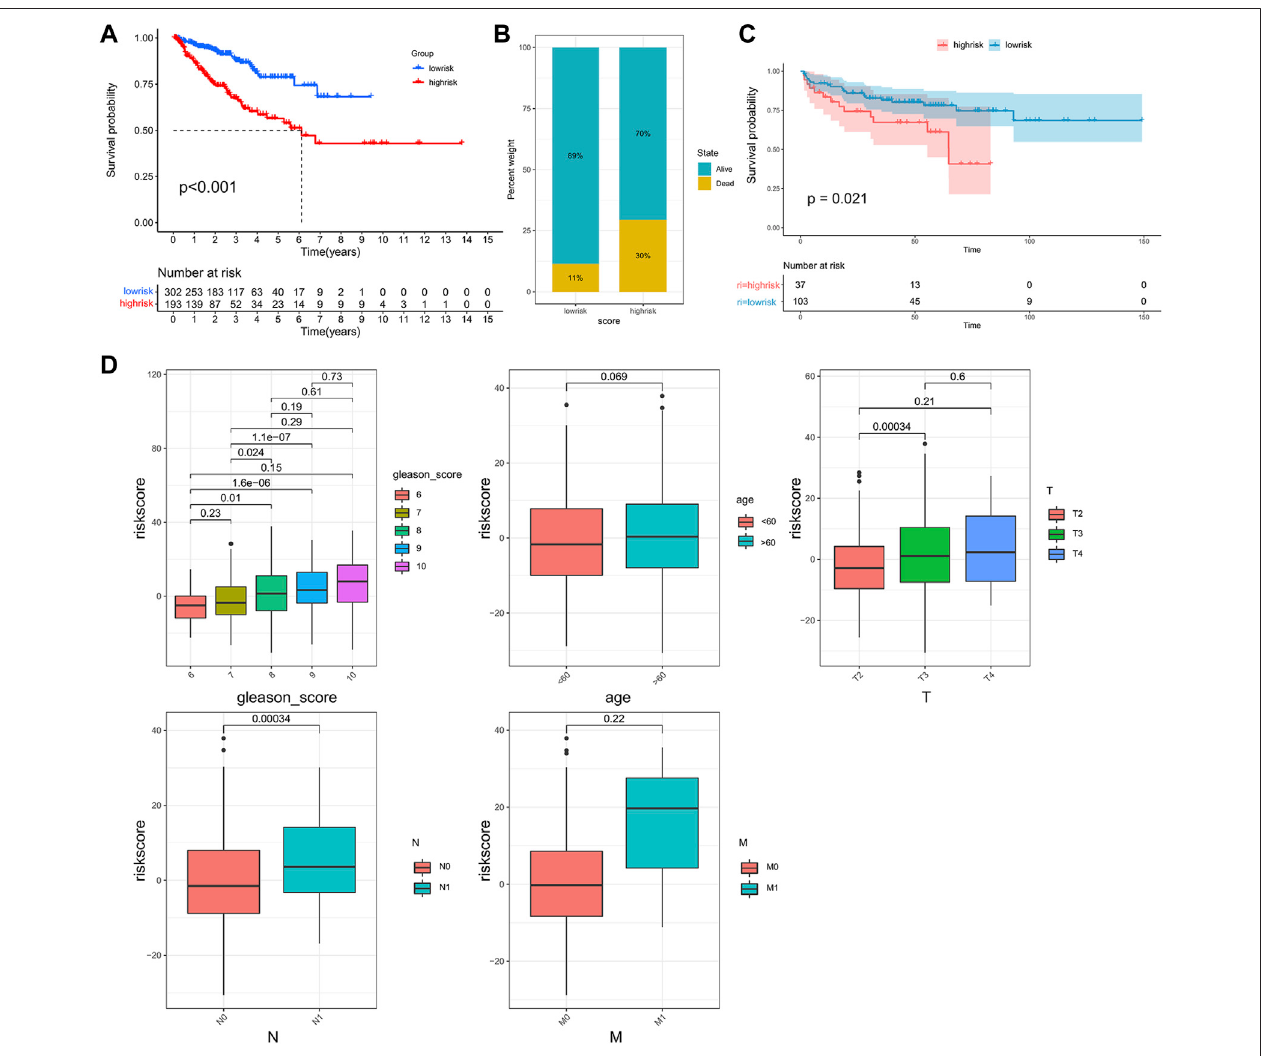
FIGURE 5 | Construction of the riskscore and prognosis analysis. (A) Kaplan – Meier survival curve between high- and low-risk subgroups in the TCGA cohort. (B) Theproportionofthesurvivalratebetweenthehigh-andlow-risksubgroups. (C) Kaplan – Meiersurvivalcurvebetweenthehigh-andlow-risksubgroupsinthevalidation cohort, GSE21034. (D) The differences in riskscore between patients with different clinicopathological parameters (Gleason score, age, T stage, N stage, M stage).